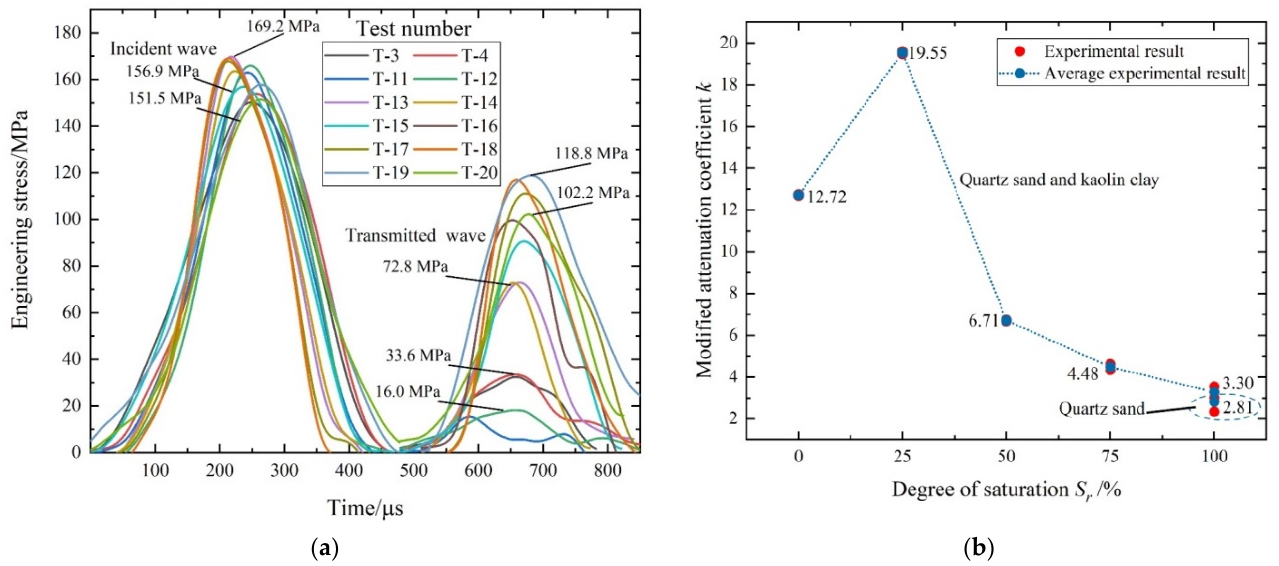
S correspond to: ( a ) incident wave r